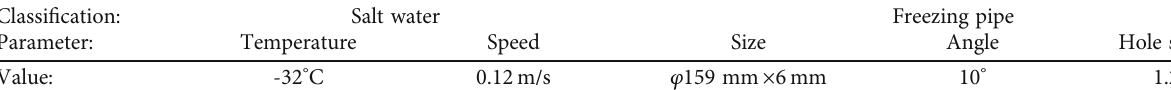
Table 1: Prototype parameters of the freezing